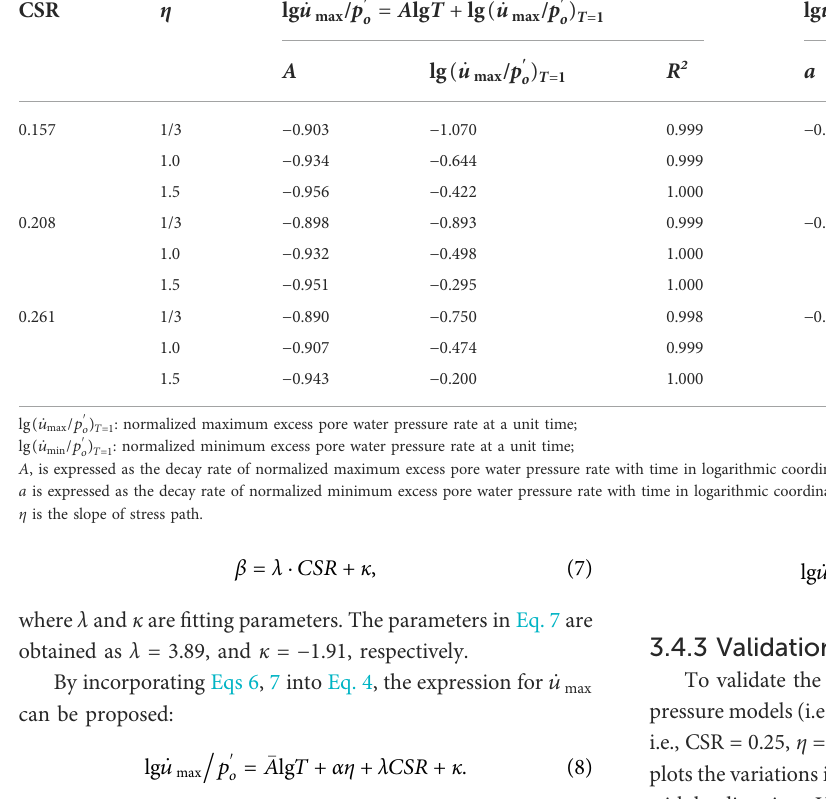
TABLE 6 Fitting parameters of Eqs 4, 5 based on the test results from Gu (2012). CSR η